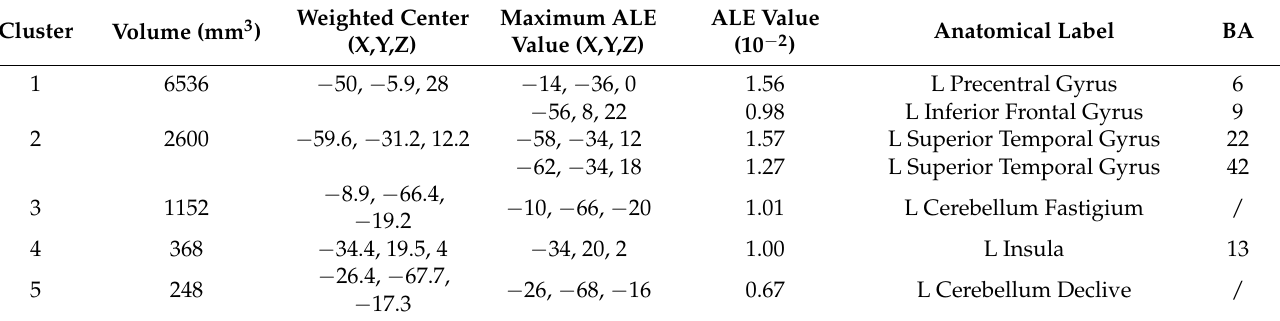
Table 4. Overlapping clusters between PWNS and PWS group found by ALE